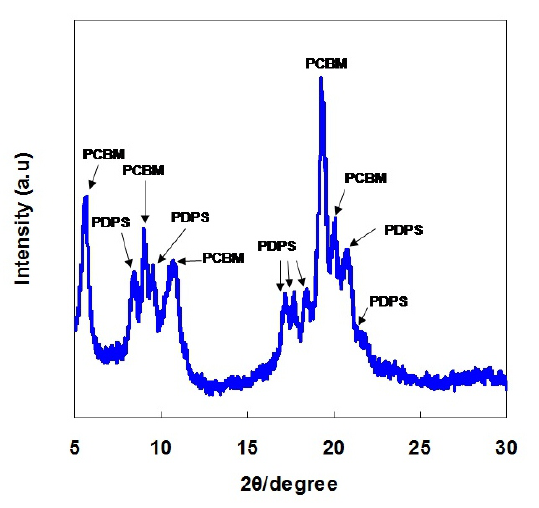
Figure 5. X-ray diffraction pattern of PDPS:PCBM thin films